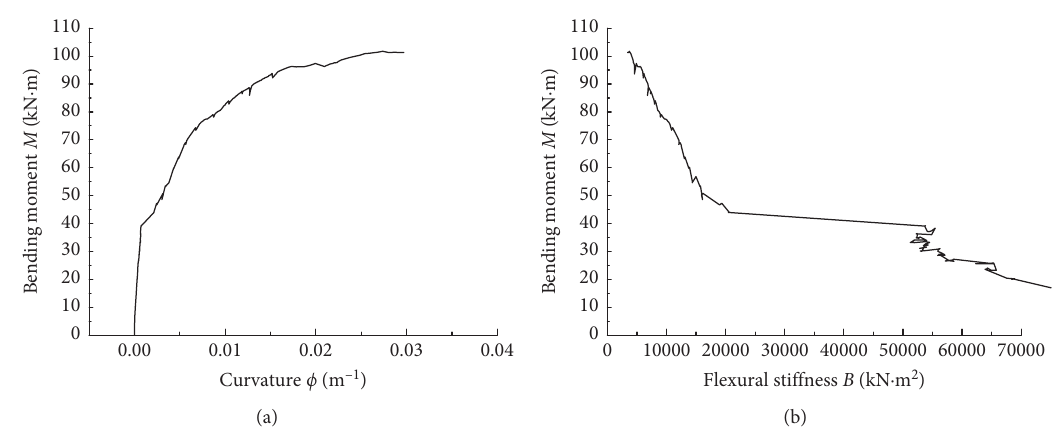
Figure 8: B-1-40-4. (a) Bending moment-curvature curve. (b) Bending moment-stiffness curve.